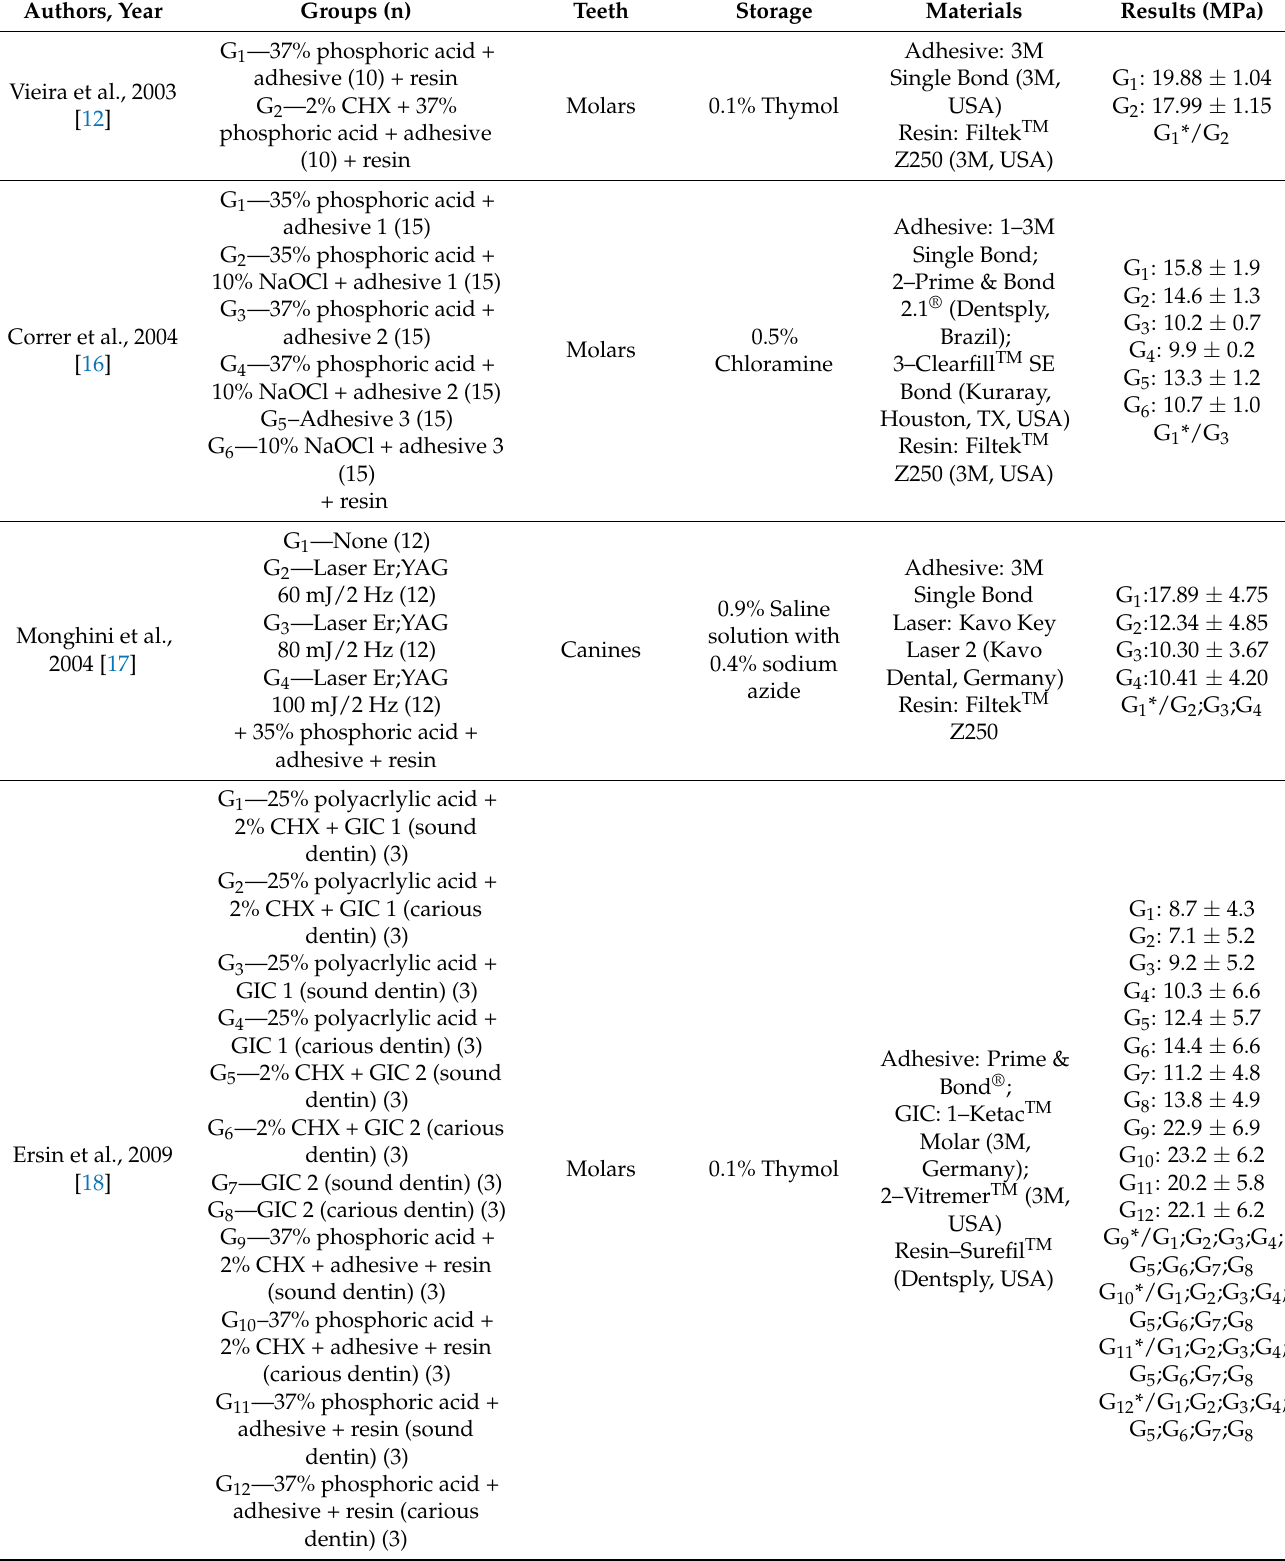
Table 1. Characteristics of the in vitro studies included in the systematic